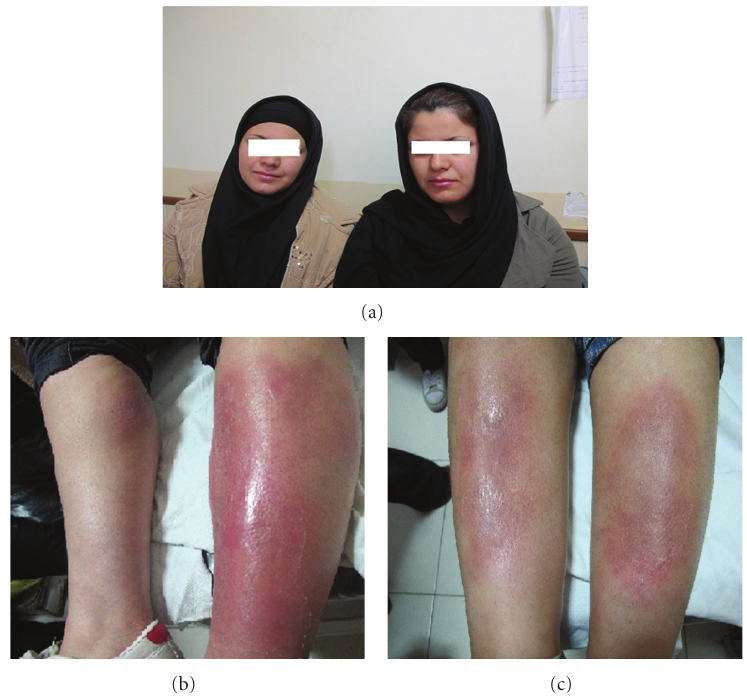
Figure 1: Skin lesions: case 1 on the right side and case 2 on the left